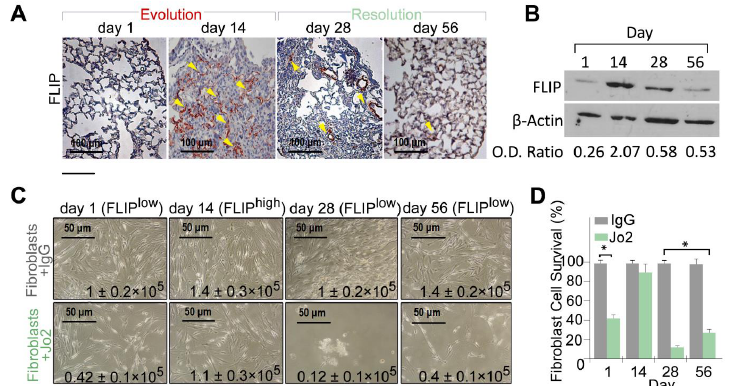
Figure 1. Lung fibrosis resolution in mice correlates with loss of Flice-like-inhibitory-protein (FLIP) and of myofibroblast viability. ( A ) FLIP (arrows) in bleomycin (BLM)-treated murine lung tissue, before fibrosis (day 1), with fibrosis (day 14) and at resolution (day 28, 56). Representative of 15 fields ( × 20) in each mouse. n = 4 for each time point. ( B ) Representative western blot of FLIP protein expression in 3 × 10 5 myofibroblasts isolated from lungs of mice at days 1, 14, 28, and 56 post BLM. ( C ) Light microscopy images with trypan blue exclusion (inserted numbers), and ( D ) graphical presentation of cell viability (%), in control-IgG vs. Jo2 (20 µ g, 48 h) anti-Fas mAb-treated fibroblasts from days 1, 14, 28, and 56 post BLM. * p =